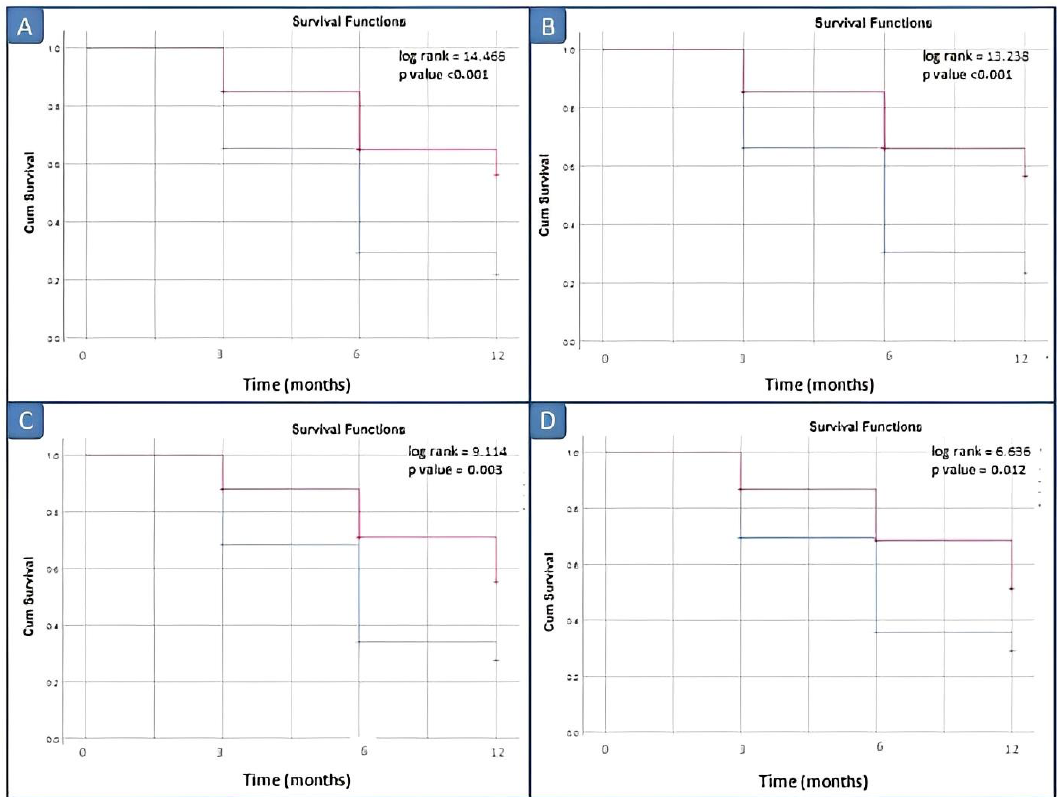
Figure 5. Survival analysis in active JIA patients by different cut-off values of calprotectin. ( A ) Cut-off of 10 ng/mL; ( B ) cut-off of 12 ng/mL; ( C ) cut-off of 15 ng/mL; ( D ) cut-off of 20 ng/mL. Blue line: negative patients, i.e., basal calprotectin value < cut off; red line: positive patients, i.e., basal calprotectin value ≥ cut off.